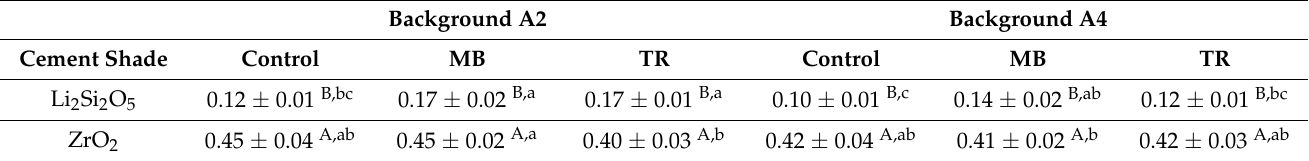
Table 2. Means and standard deviation for CR. Different superscript capital letters indicate significant difference within column ( p < 0.05). Different superscript lower-case letters indicate significant difference within rows ( p < 0.05).